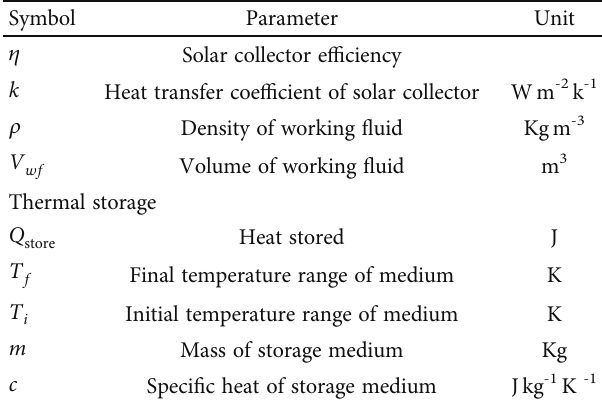
Table 2: List of symbols. Table 2: